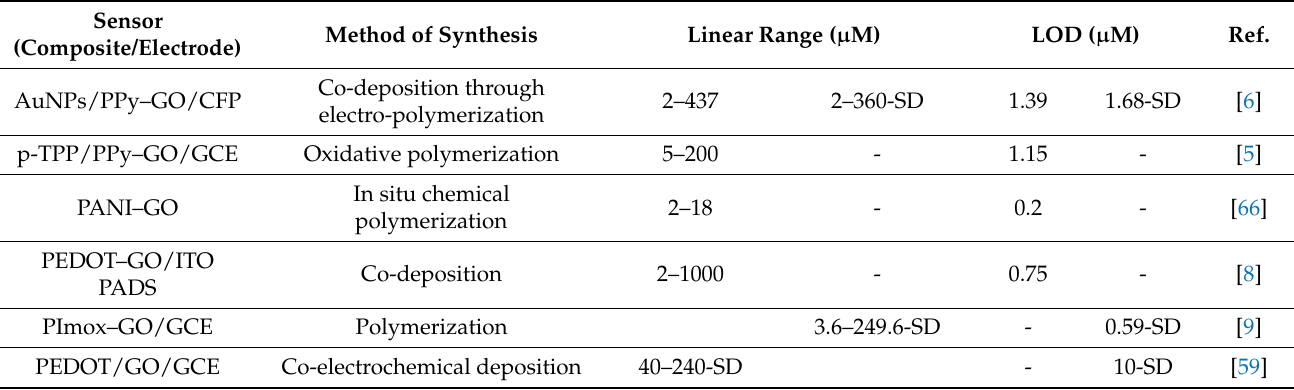
Table 2. Synthesis methods and composites used for the preparation of electrodes for use in sensorial platforms, as well as their